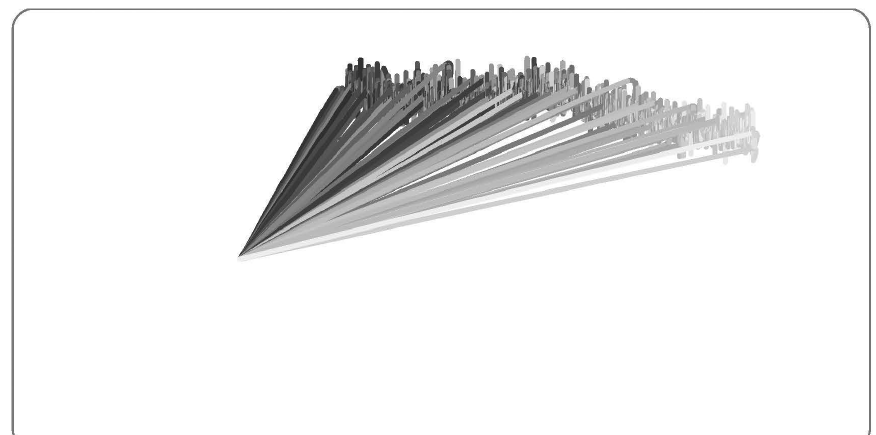
FIGURE 9 (e) - X-ray diffraction analysis of formulation